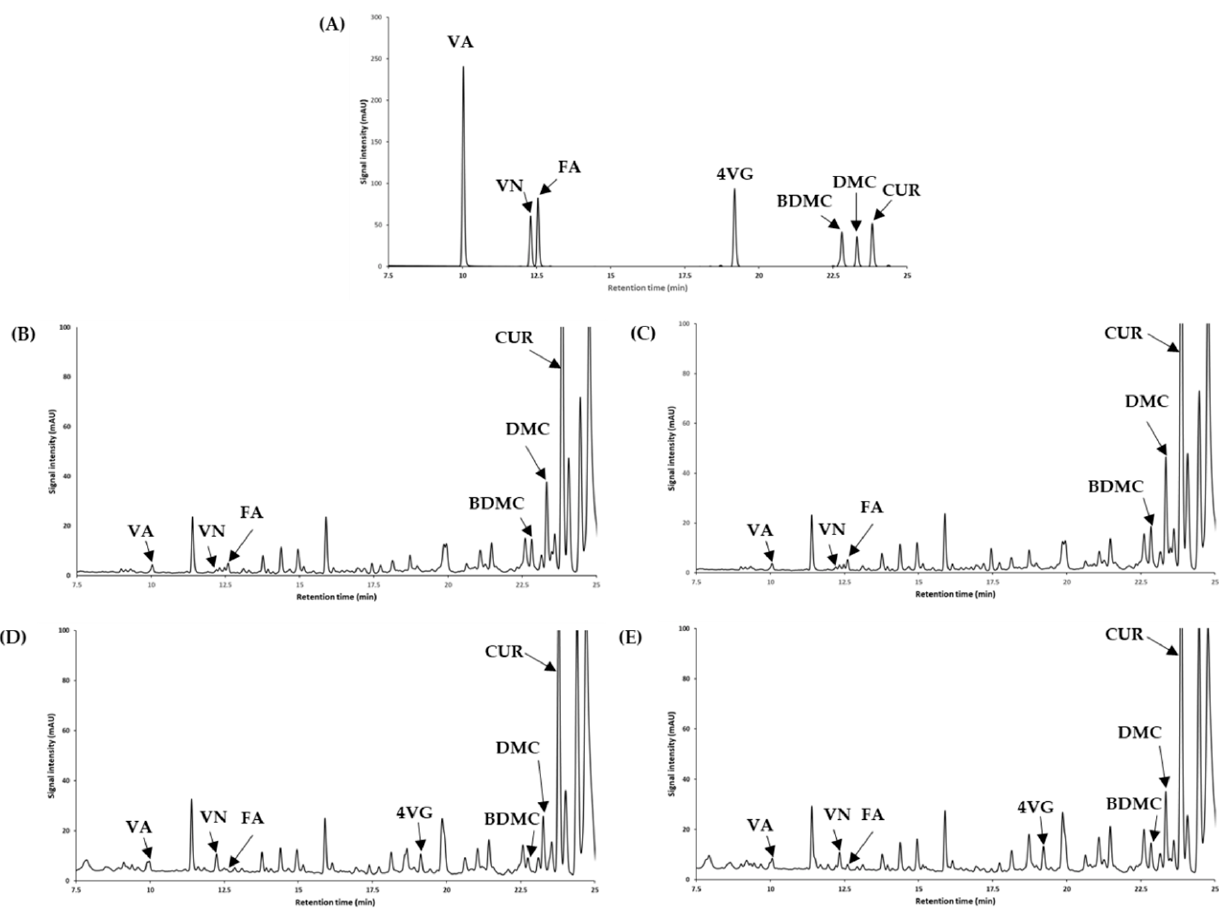
Figure 3. HPLC chromatograms of seven standard materials including curcuminoids and their degradation products ( A ), turmeric extract ( B ), HHPE turmeric ( C ), puffed turmeric ( D ), and puffed and HHPE turmeric ( E ) for quantification. VA, vanillic acid; VN, vanillin; FA, ferulic acid; 4VG, 4- vinyl guaiacol; BDMC, bisdemethoxycurcumin; DMC, demethoxycurcumin; CUR, curcumin.